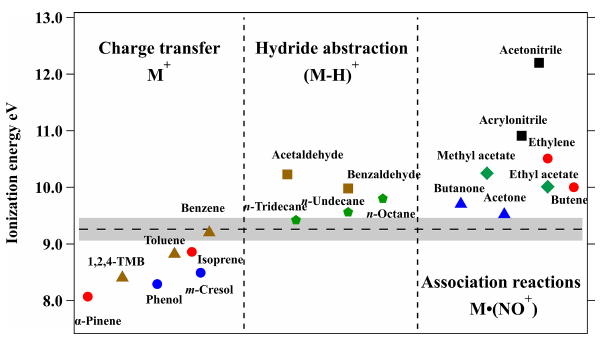
Figure 1. Ionization energy (IE) and reaction pathways with NO + ions of organic compounds including alkanes (green pentagon), aro- matics (brown triangle), alkenes (red circle), phenolic species (blue circle), aldehydes (brown square), ketones (blue triangle), esters (green diamond), and nitrogen-containing species (black square). The ionization energy of NO (9.26eV) is represented by the dashed line, with shading representing reported uncertainty. The IE of various organic compounds can be obtained in the NIST Chem- istry WebBook (http://webbook.nist.gov, last access: 29 Novem- ber 2022). The abbreviation “1,2,4-TMB” corresponds to 1,2,4-